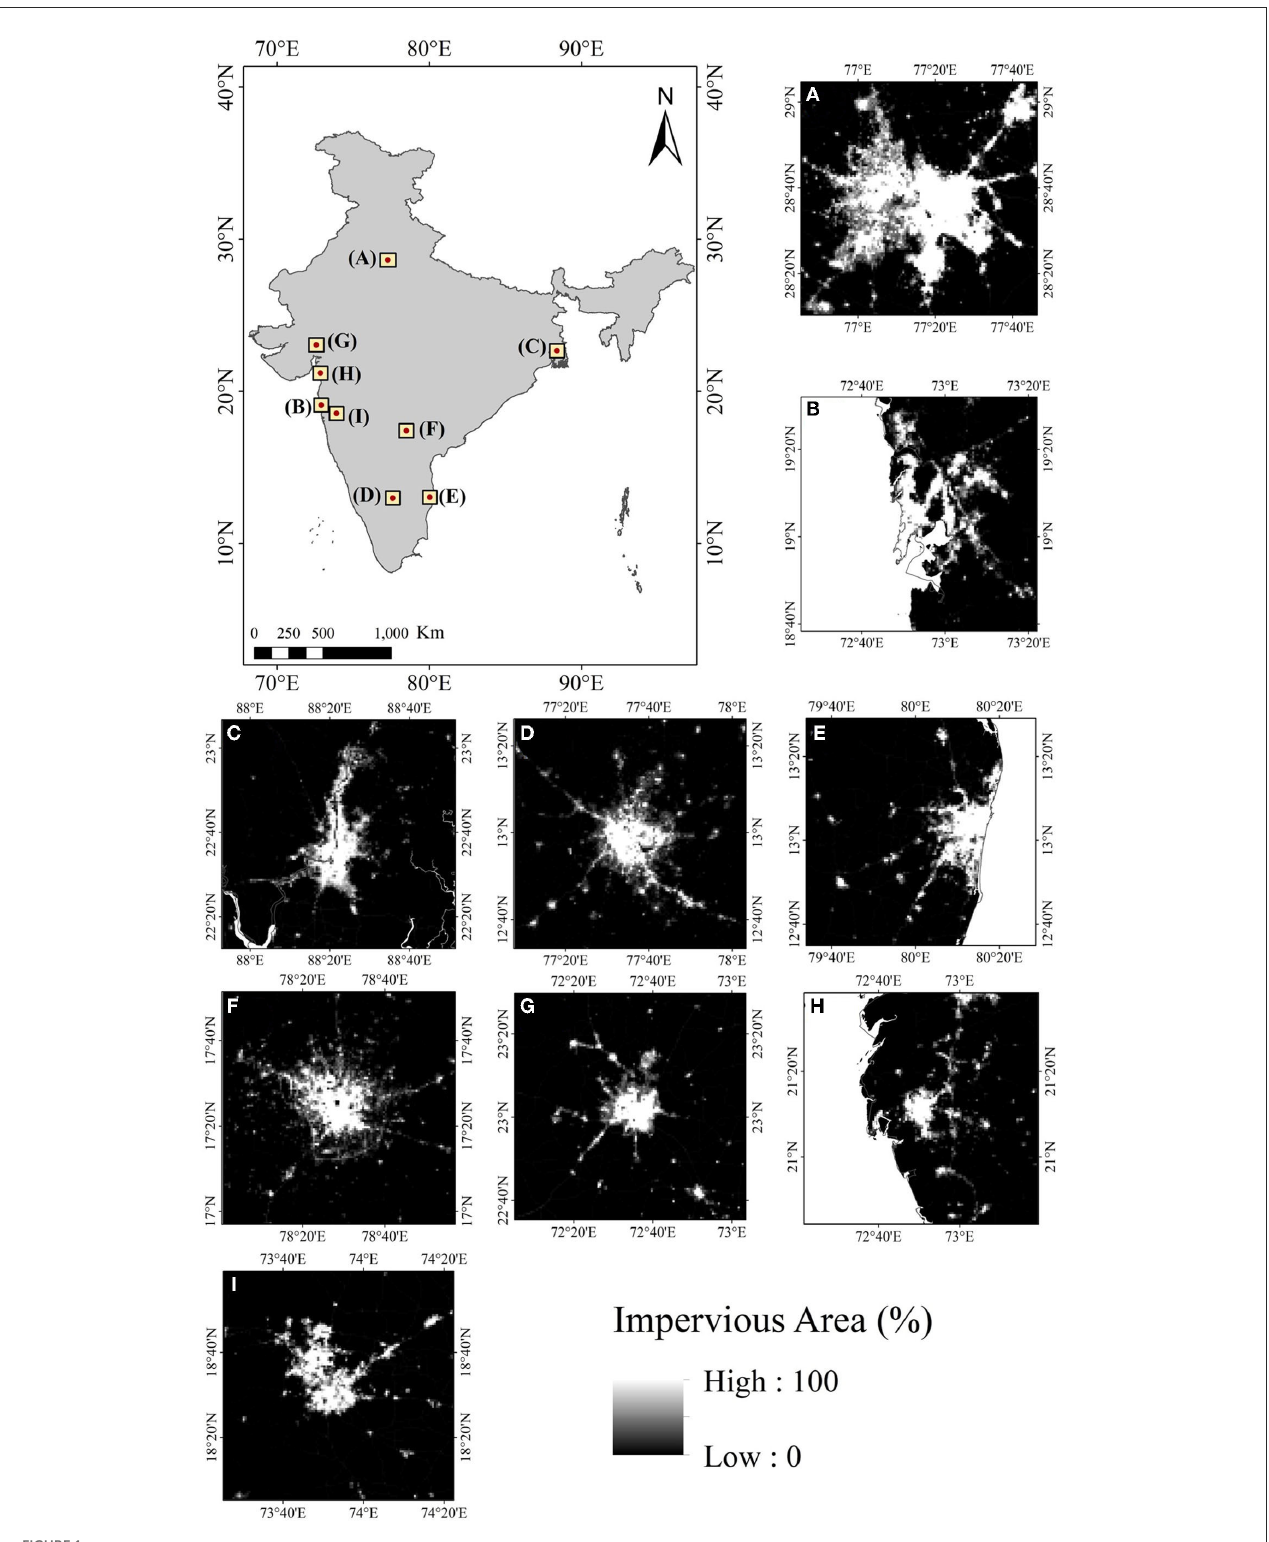
FIGURE1 Study area showing geographical location of the nine major populated cities of India within its national boundary (shaded in gray). The cities are represented by a red dot within the 100km surrounding boxes (shaded in yellow; box outlines in black) marking the region of interest. Impervious area (%) based on GMIS dataset for the year 2010 (Wang et al., 2017) for cities (A) Delhi, (B) Mumbai, (C) Kolkata, (D) Bangalore, (E) Chennai, (F) Hyderabad, (G) Ahmedabad, (H) Surat, and (I) Pune is provided alongside. The figures are generated with ArcMap ver.